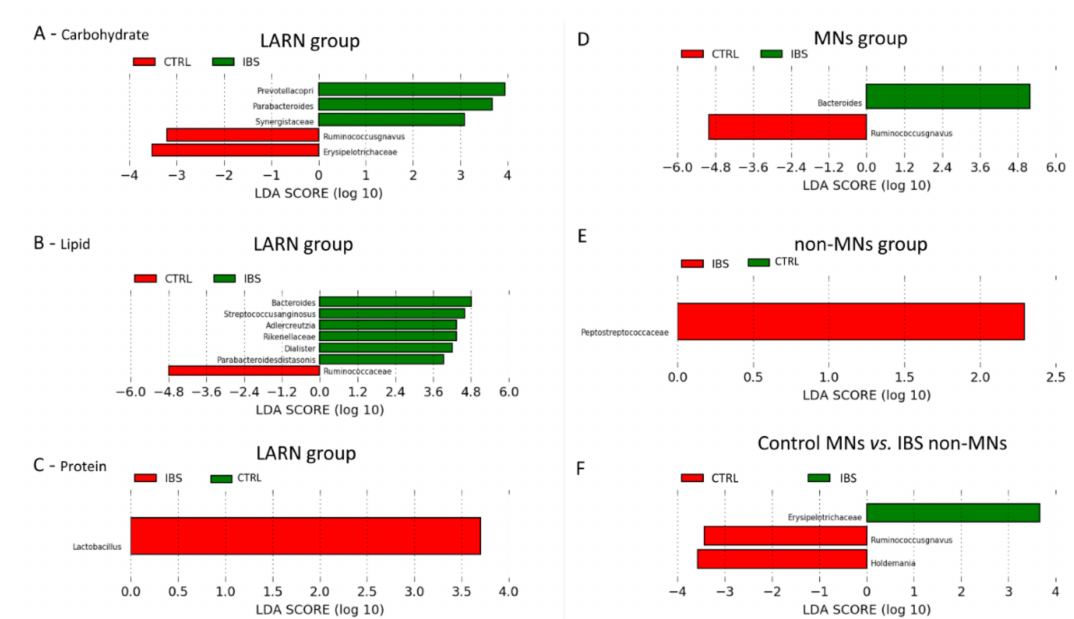
Figure 2. LEfSe analysis of taxonomic biomarkers of gut microbiota of IBS vs. control for carbohydrate, fat, protein and all macronutrients intake. ( A ) Comparison between IBS vs. control samples grouped by carbohydrate intake (LARN group); ( B ) comparison between IBS vs. control samples grouped by lipid intake (LARN group); ( C ) comparison between IBS vs. control samples grouped by protein intake (LARN group); ( D ) comparison between IBS vs. control samples grouped by all macronutrients intake (MNs group); ( E ) comparison between IBS vs. control samples grouped by macronutrient intake (non-MNs group); ( F ) comparison between IBS non-MNs group vs. control MNs